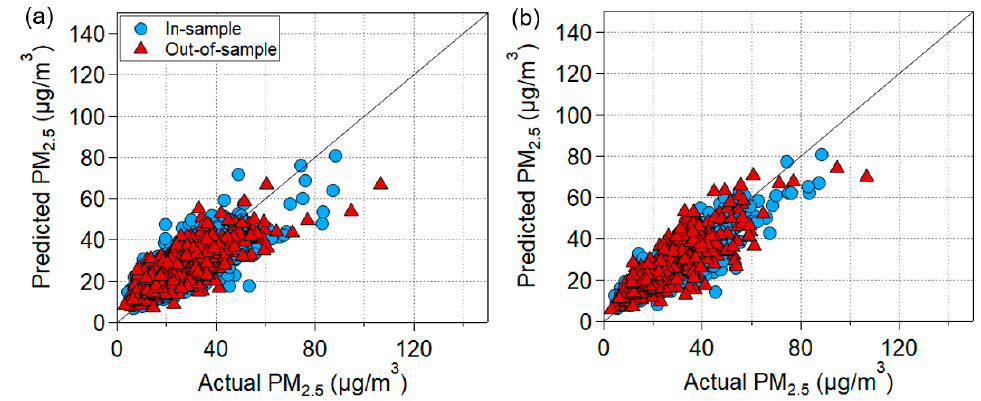
Figure 7. PM 2.5 prediction vs. actual PM 2.5 for nationwide model: ( a ) not considering accurate weather prediction and ( b ) considering accurate weather prediction.